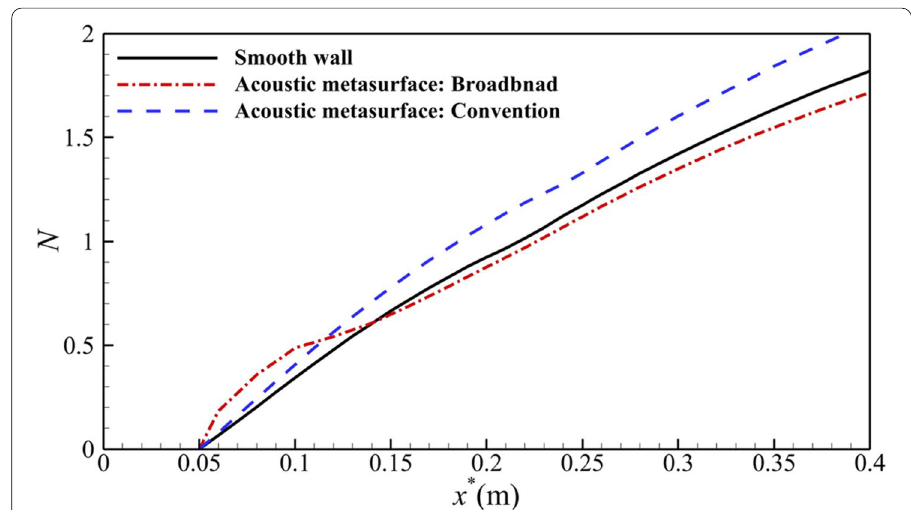
Fig. 9 Comparison of N -factor envelopments of different surfaces